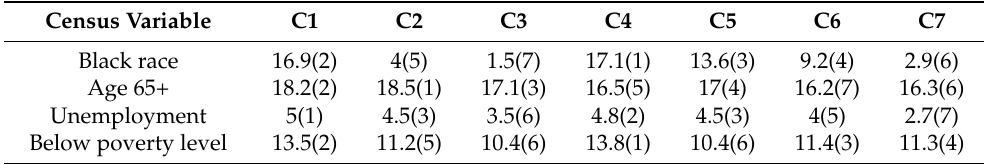
Table 1. Characterization (in terms of median and rank) of the seven groups of COVID-19 spread patterns across the 51 US states using four risk factors from 2019 US census data.